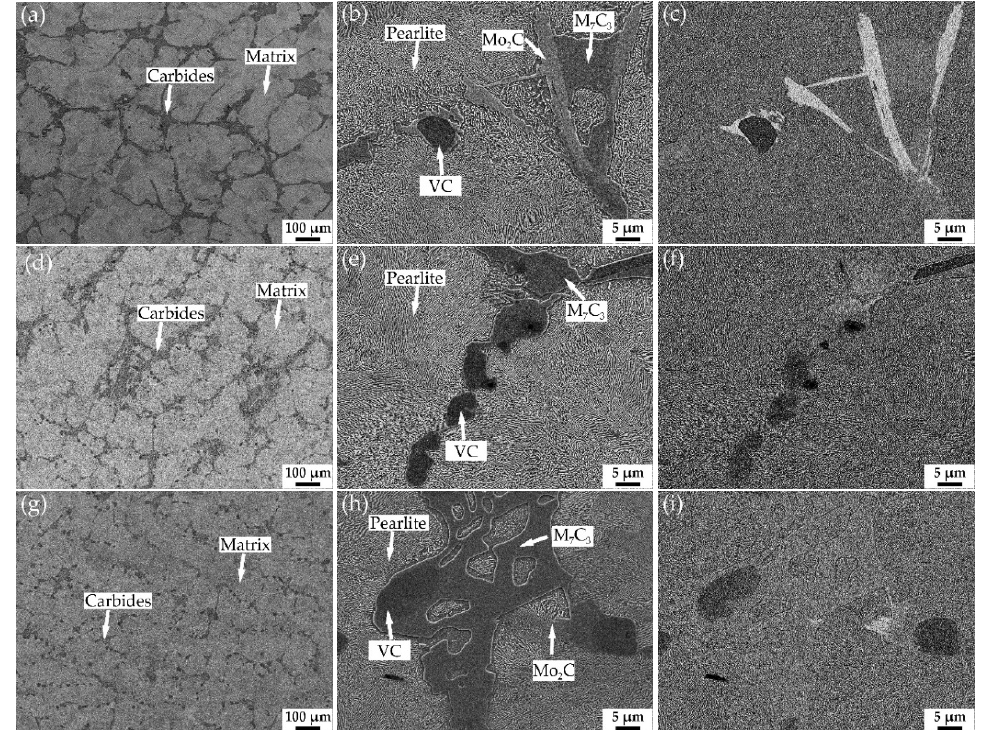
Figure 1. SEM images of the annealed specimens, SE images of V1: ( a , b ), BSE image of V1: ( c ), SE images of V2: ( d , e ), BSE image of V2: ( f ), SE images of V3: ( g , h ), BSE image of V3: ( i ).